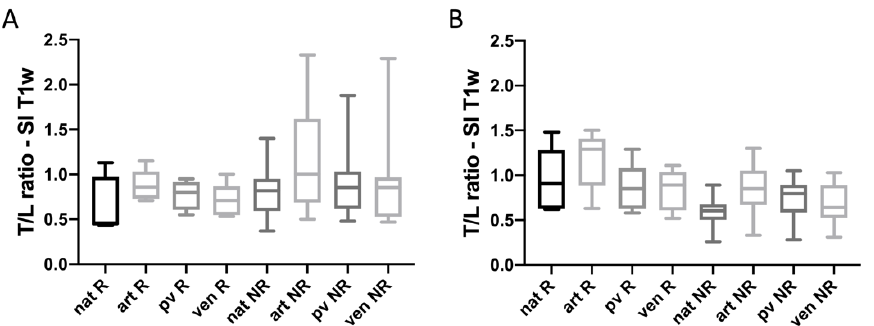
Figure 7. Analysis of T/L ratio of SI of T1w on non-enhanced, arterial, portal-venous and venous phase for responding NELMs (PFS > 11 m) and non-responding NELMs (PFS < 11 m) on pretreatment images ( A ) and first FU MRI ( B ).